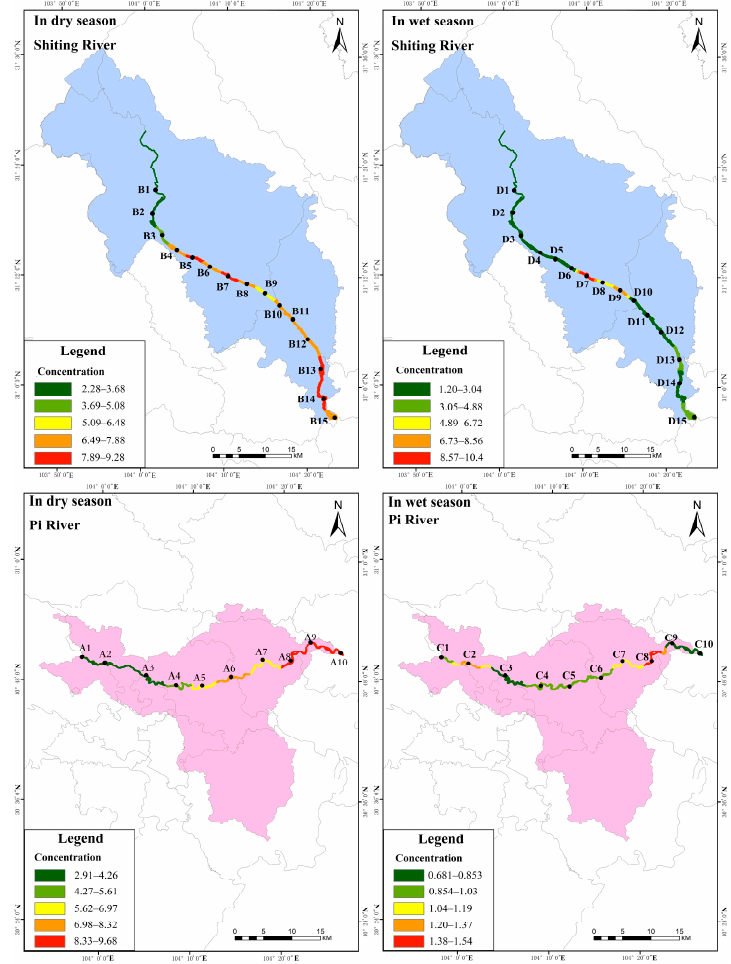
Figure 4. Spatial distribution of TN in water of the study area.